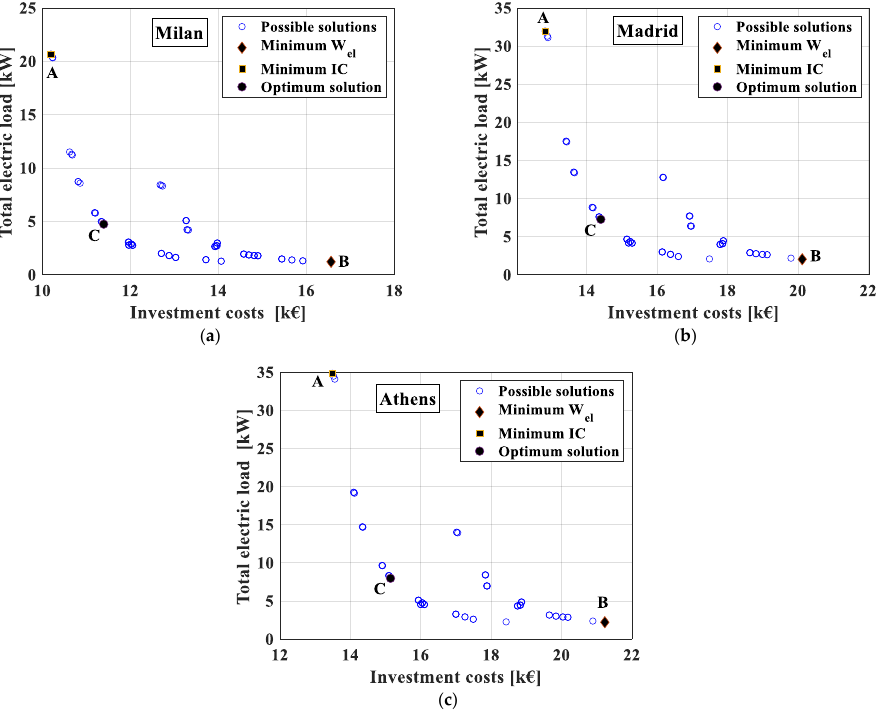
Figure 4. Total electric load of all feasible hybrid ejector configurations as function of set-up costs for ( a ) Milan, ( b ) Madrid, ( c ) Athens. The distinctive points represent the arrangement characterized by the minimum costs A, the one with minimum electric load B and the optimal one C identified by the best compromise between performance and costs.